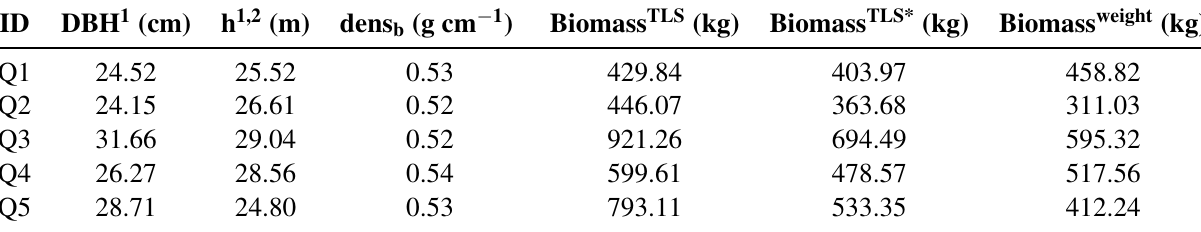
Table A1. Results for Q. petraea